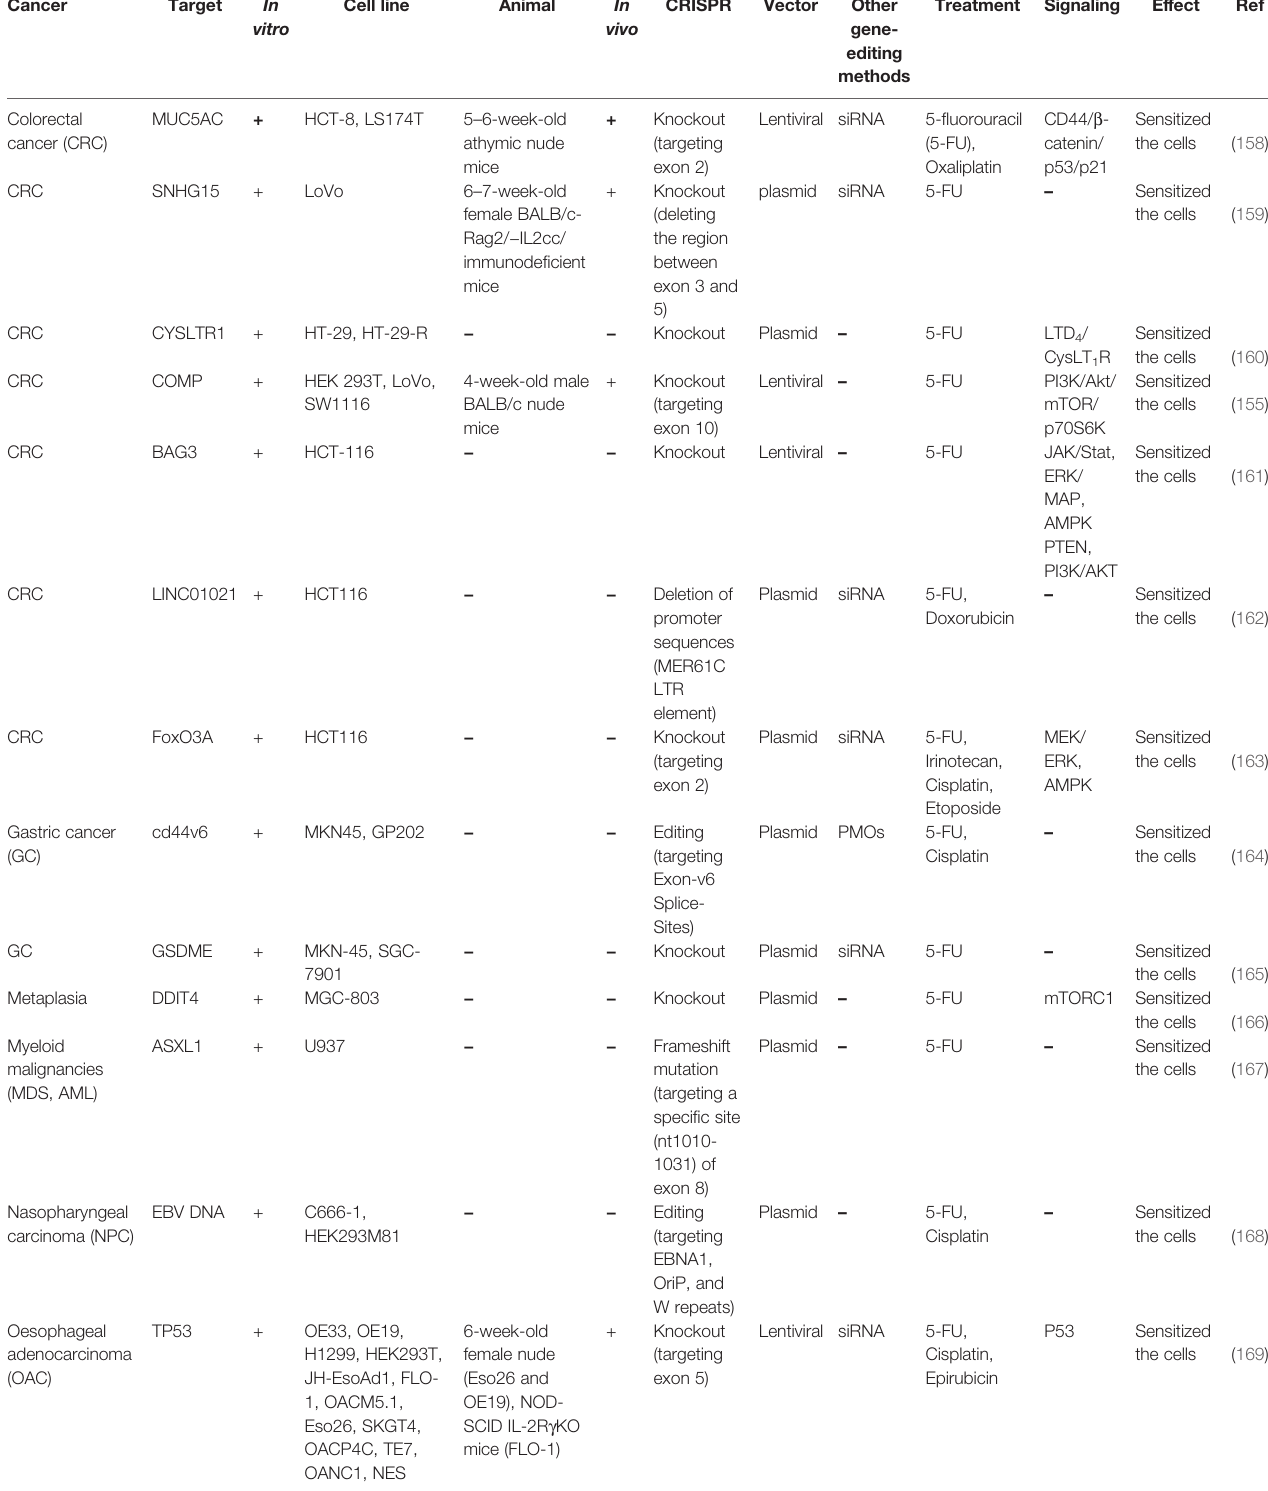
TABLE 9 | Pre-clinical studies employing CRISPR/Cas9 to recognize the role of various genes in response to 5-FU